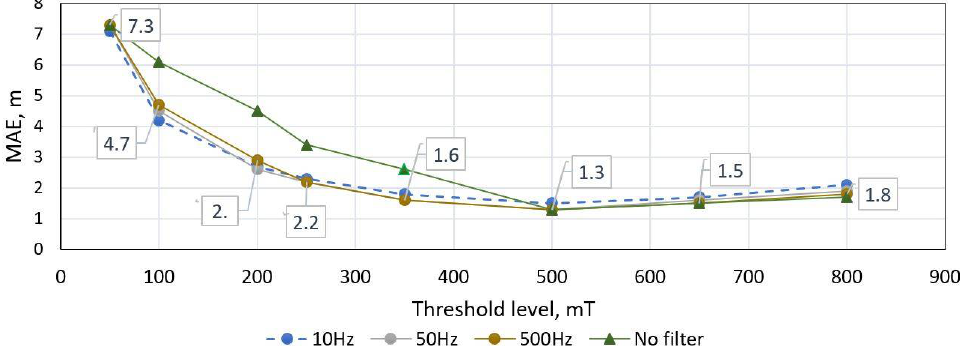
Figure 9. Threshold-based length estimation method MAE score versus low pass filtering (fc) and threshold value. Dataset of 300 unique vehicle used.